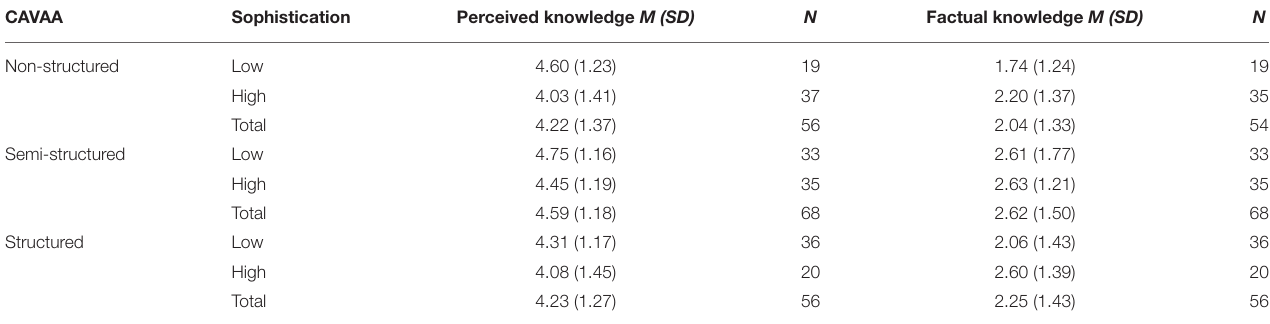
TABLE 5 | Means and Standard Deviations of perceived knowledge (ranging from 1 - a low score to 7 - high score) and factual knowledge (ranging from 0 - a low score to 6 - a high score) in each condition. CAVAA Sophistication Non-structured